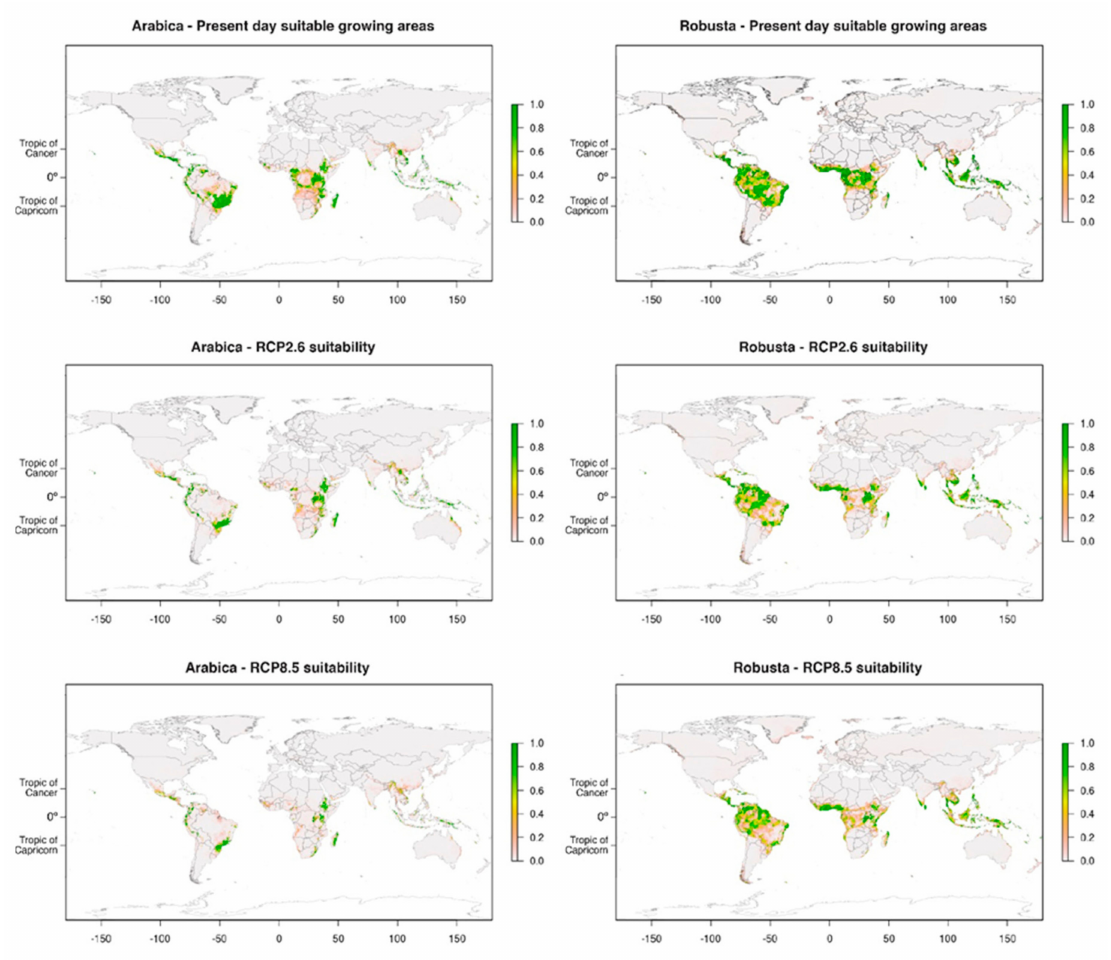
Figure 1. Present-day and future suitability maps for Arabica and Robusta. A value of 1 indicates a high probability (certainty) of species presence in the region, while a value of 0 indicates a very low probability of species presence on the basis of bioclimate conditions. Future scenarios presented are those of the Intergovernmental Panel on Climate Change (IPCC) (2013) RCP 2.6 and 8.5 for